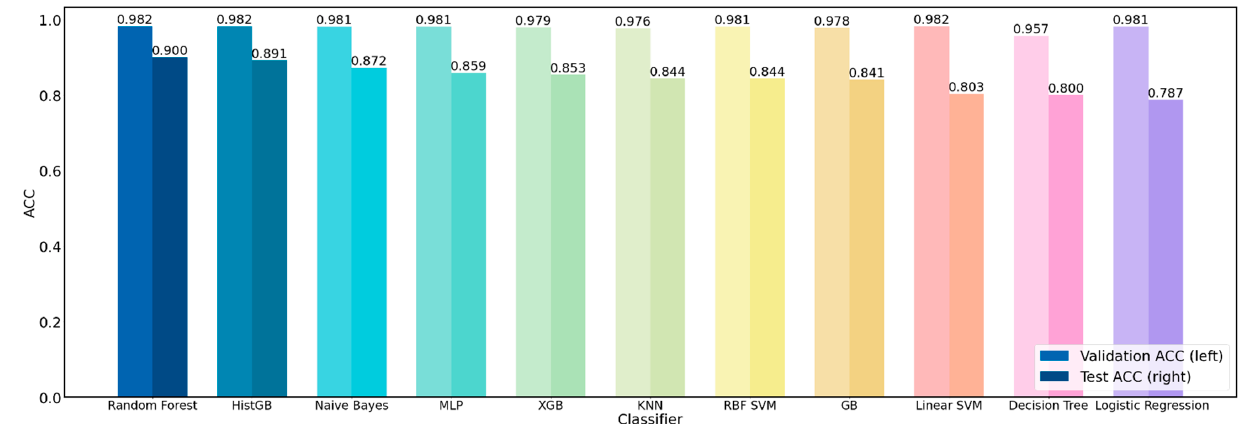
Figure 5. Comparison of performance of 11